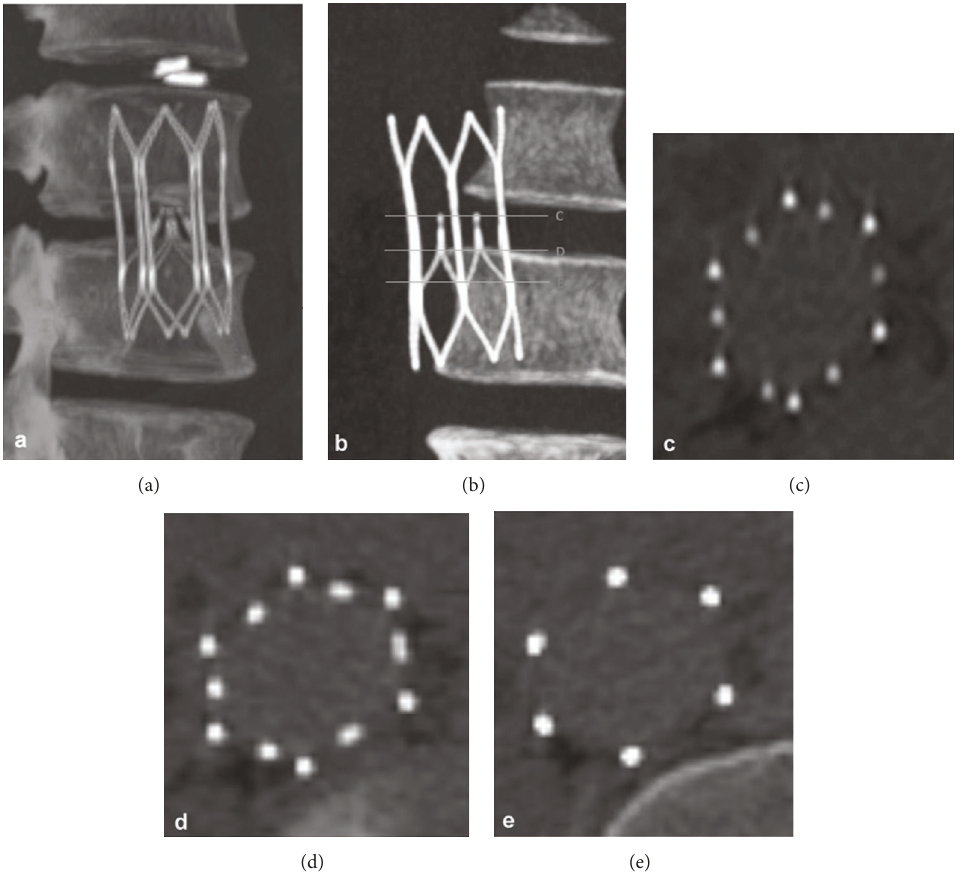
Figure 4: Computed tomography imaging of the Sentry bioconvertible IVC filter for a single patient. (a) Coronal image acquired as part of helical dataset 1 month after filter placement, showing the Sentry device in filtering configuration. (b) Coronal image at 6-month follow-up showing the device in bioconverted configuration. ((c), (d), (e)) Axial views of the bioconverted device at 6-month follow-up, with the images keyed to the coronal view in (b). Reprinted with permission from Dake et al.